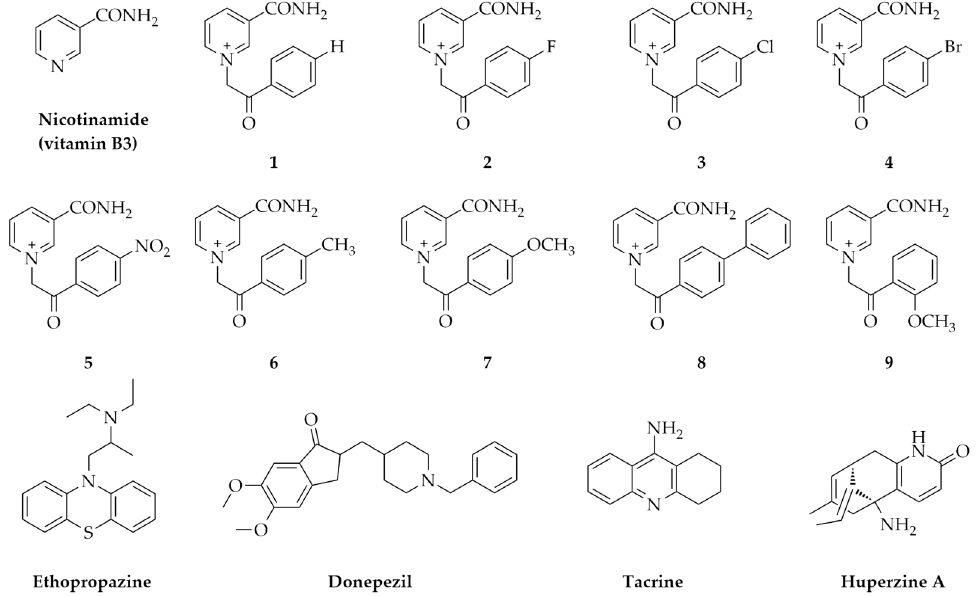
Figure 1. Chemical structures of tested vitamin B3-derivatives 1 - 9 (nicotinamide form) and known ChE acting drugs (reversible inhibitors).